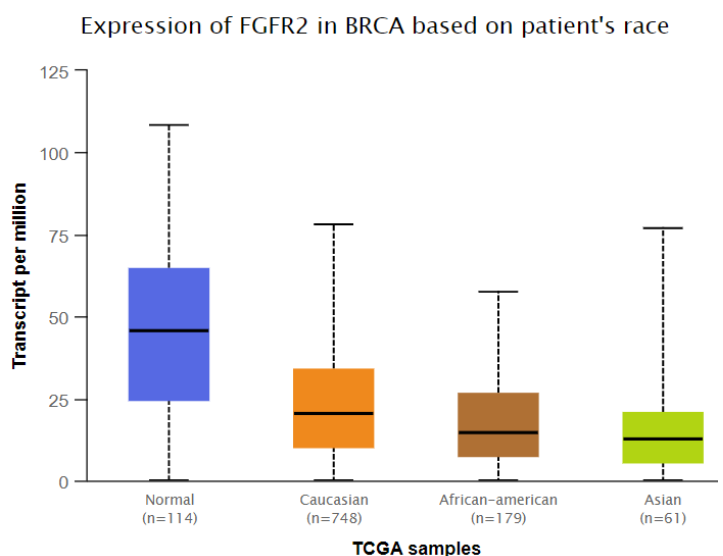
Figure 3. Association of FGFR2 expression in different ethnic populations (Normal vs. Caucasian: p = 8.79 × 10 − 1 , Normal vs. African American: p = 2.09 × 10 − 12 , Normal vs. Asian: p = 2.83 × 10 − 4 ). Data from the UALCAN database were extracted (http://ualcan.path.uab.edu/, accessed on 20 November,